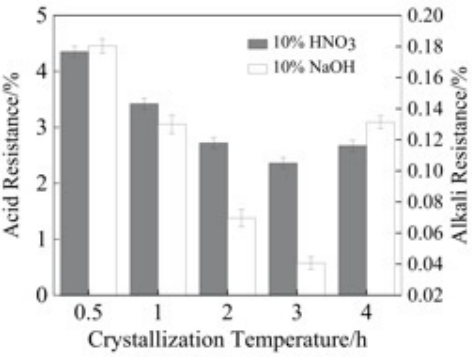
Figure 16. Effects of crystallization time on the acid and alkali resistances of the microcrystalline glass.